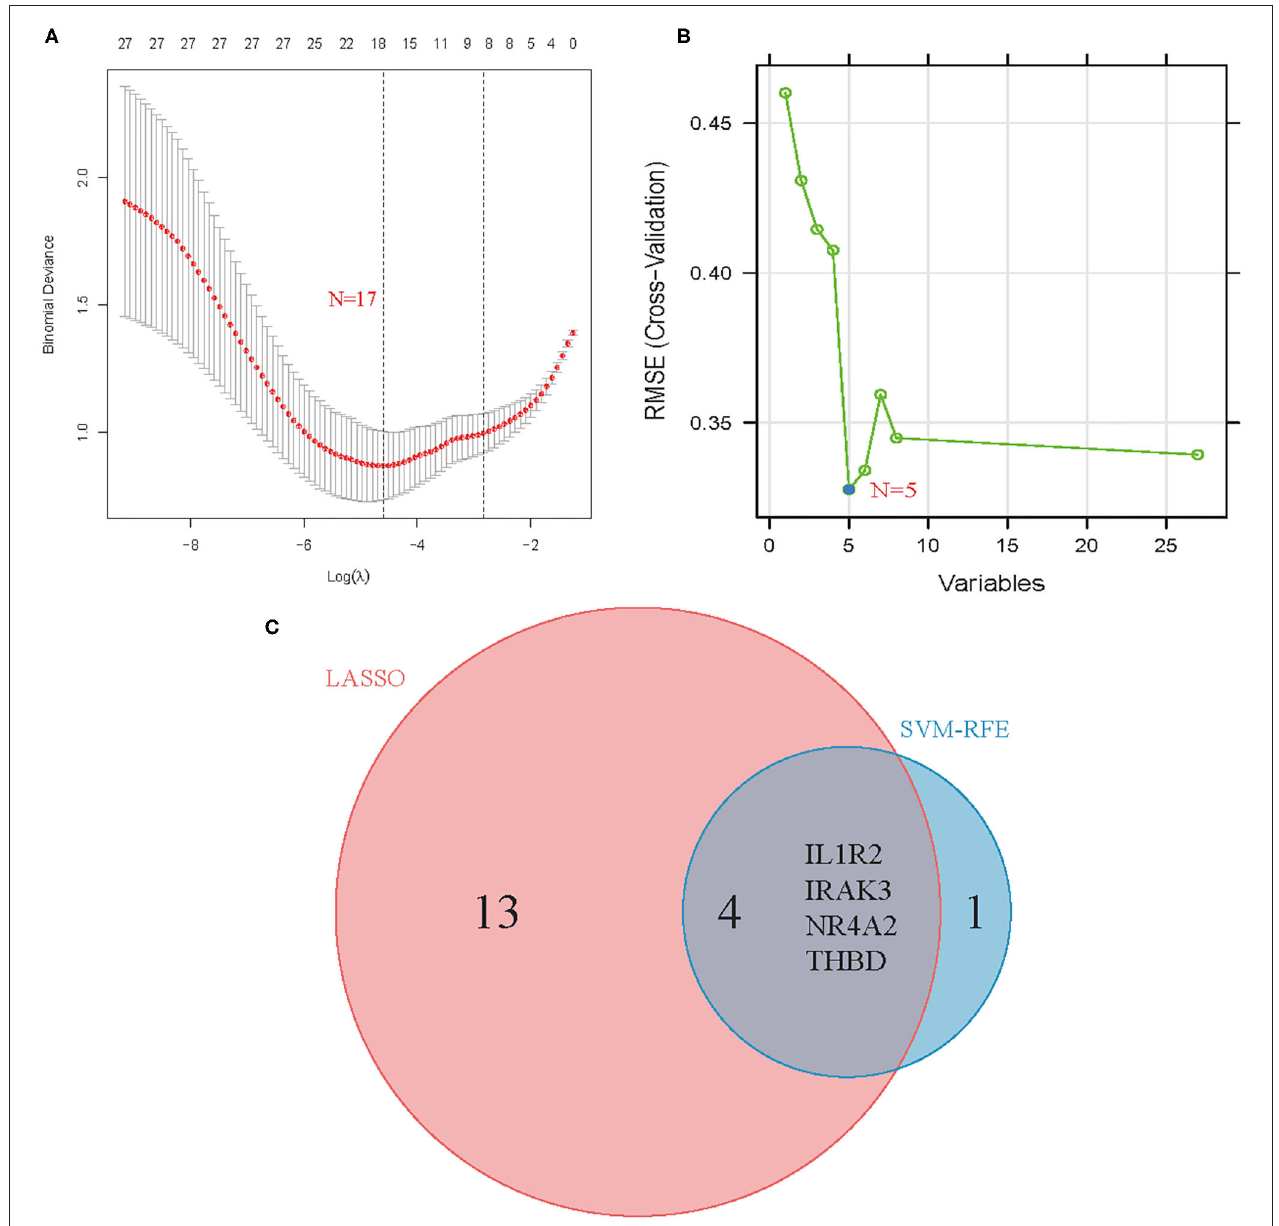
FIGURE 3 | Screening process of diagnostic biomarker candidates for acute myocardial infarction diagnosis. (A) Tuning feature selection in the least absolute shrinkage and selection operator model. (B) A plot of biomarkers selection via support vector machine-recursive feature elimination (SVM-RFE) algorithm. (C) Venn diagram demonstrating four diagnostic markers shared by the least absolute shrinkage and selection operator and SVM-RFE algorithms.